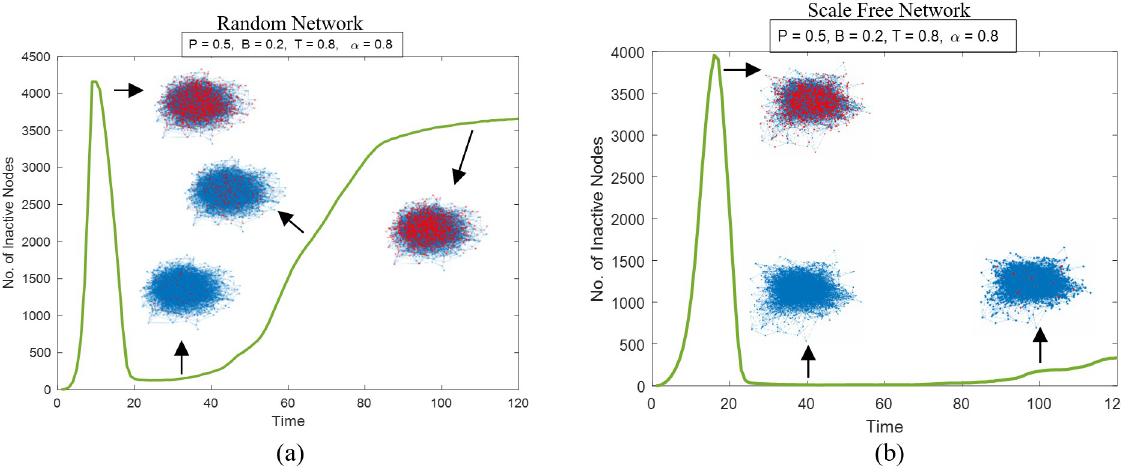
Fig 2. The number of inactive nodes as a function of time steps at higher values of P and α in (a) a random network and (b) a scale-free network. Both networks have 5000 nodes and 10000 edges. The snapshots indicate the distributions of the inactive nodes (red) and the active nodes (blue) at respective time